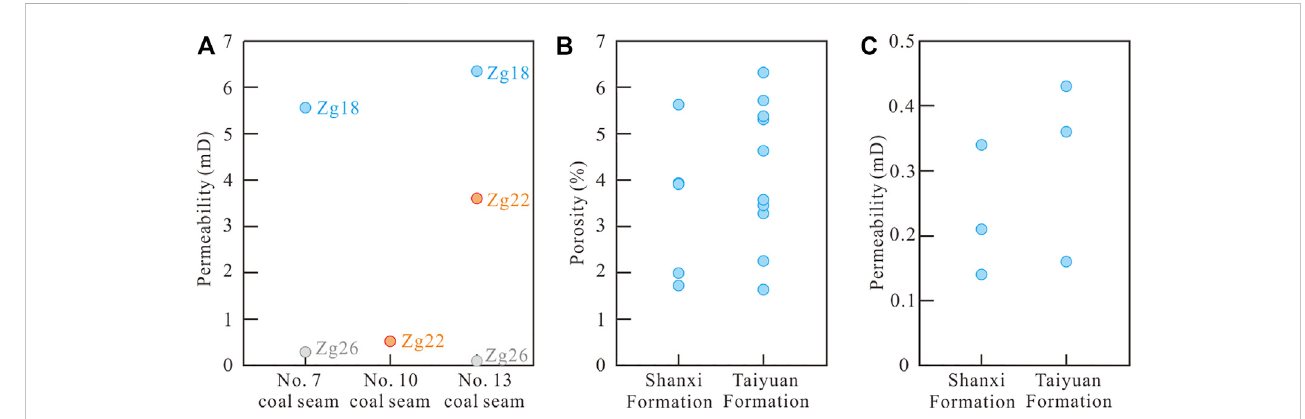
FIGURE 5 Permeability (A) of the No. 7, 10 and 13 coal seams in Wells Zg18, Zg22 and Zg26, and porosity (B) and permeability (C) of shale in the Shanxi Formation and Taiyuan Formation of Well